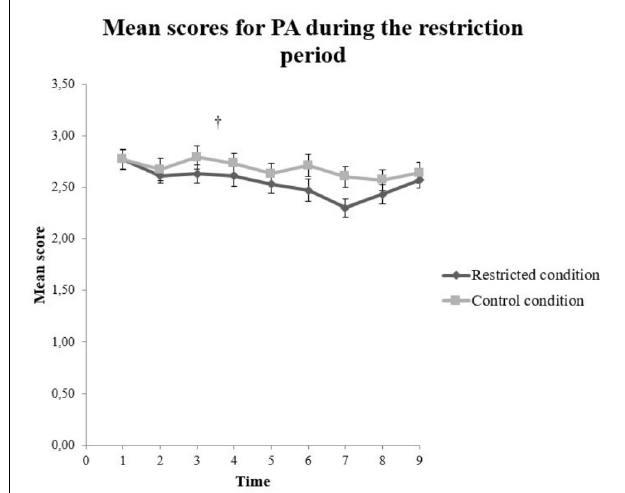
FIGURE 4 | Mean scores on the Fear of Missing Out (FOMO) Scale for the restricted ( n = 67) and control ( n = 60) condition. The error bars represent standard error mean for each value. ∗ p < 0.05 for main effect of condition, † p < 0.05 for effect of time, R p < 0.05 for Time 2 and Time 4 compared to Time 9, and R p < 0.001 for Time 1 compared to Time 9. TABLE 5 | The effect of smartphone restriction on positive affect (PANAS) scores by linear mixed models.